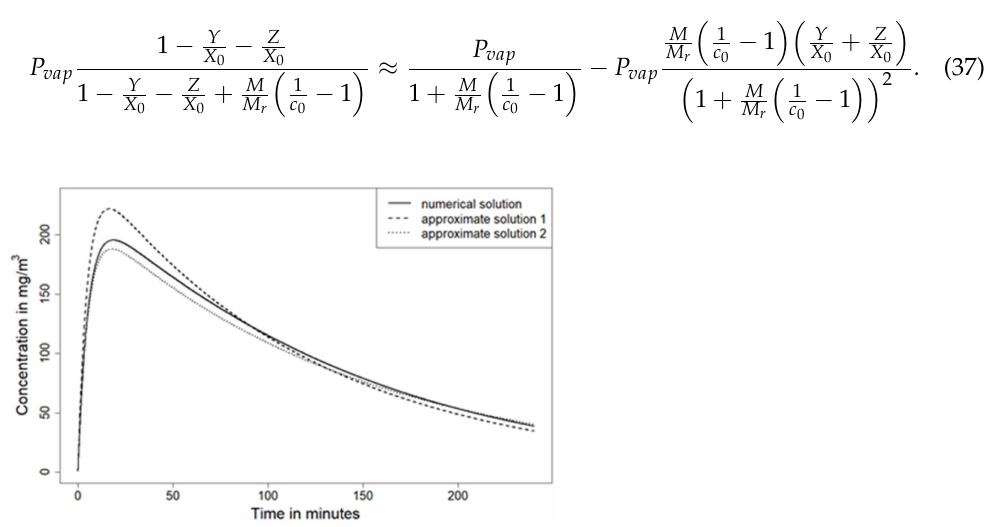
Figure 1. Substance concentration in room air using the numerical solution (solid line), the ap- proximate analytical solution (dashed line, dubbed “approximate solution 1”), and an approximate analytical solution that underestimates the rate of the evaporation process (dotted line, dubbed “approximate solution